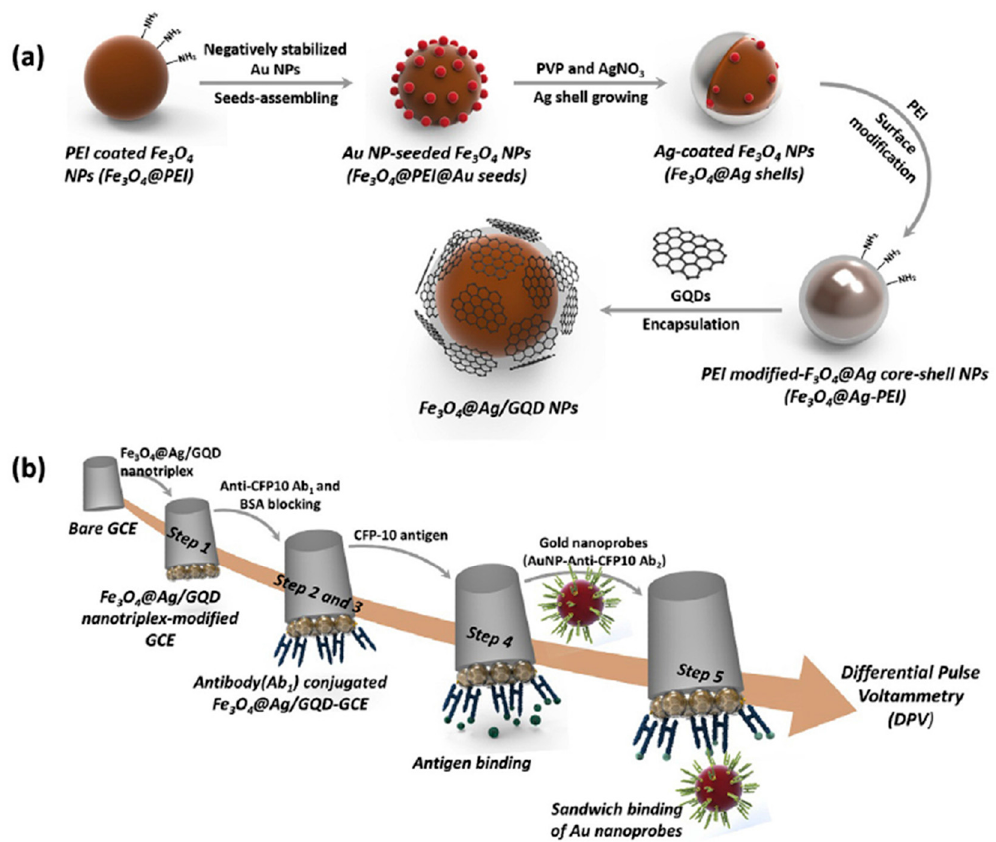
/ GQD NP nanotriplex probe ( a ) and outline of Figure 3. Synthesis of Fe 3 O 4 @Ag/GQD NP nanotriplex probe a ) and outline of inmmunosensor Figure 3. Synthesis of Fe 3 O 4 @Ag